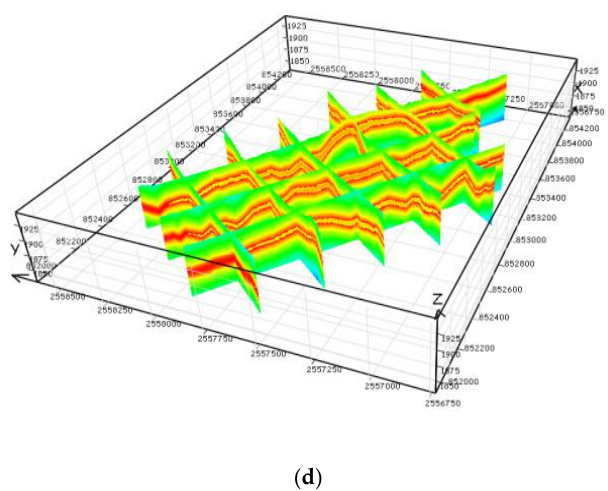
Figure 12. Fence diagrams for the four interpolation methods. ( a ) IDW interpolation; ( b ) kriging interpolation; ( c ) linear triangular prism interpolation; ( d ) quadric triangular prism interpolation.